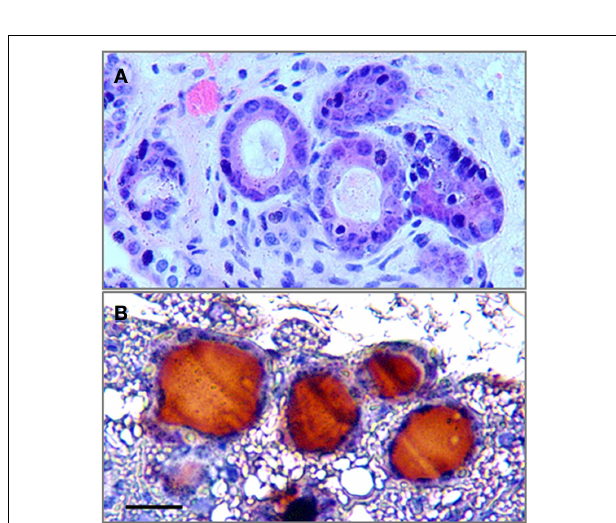
FIGURE 4 | Functionality of differentiated thyroid iPS cells . (A) Differentiated Pax8 + NKX2-1 + iPS cells demonstrated cAMP generation in response to increasing concentrations of TSH. The sensitivity of rat thyroid cells (FRTL-5) is illustrated for comparison within the same experiment. (B) Differentiated Pax8 + NKX2-1 + iPS cells were exposed to 125 I (as described